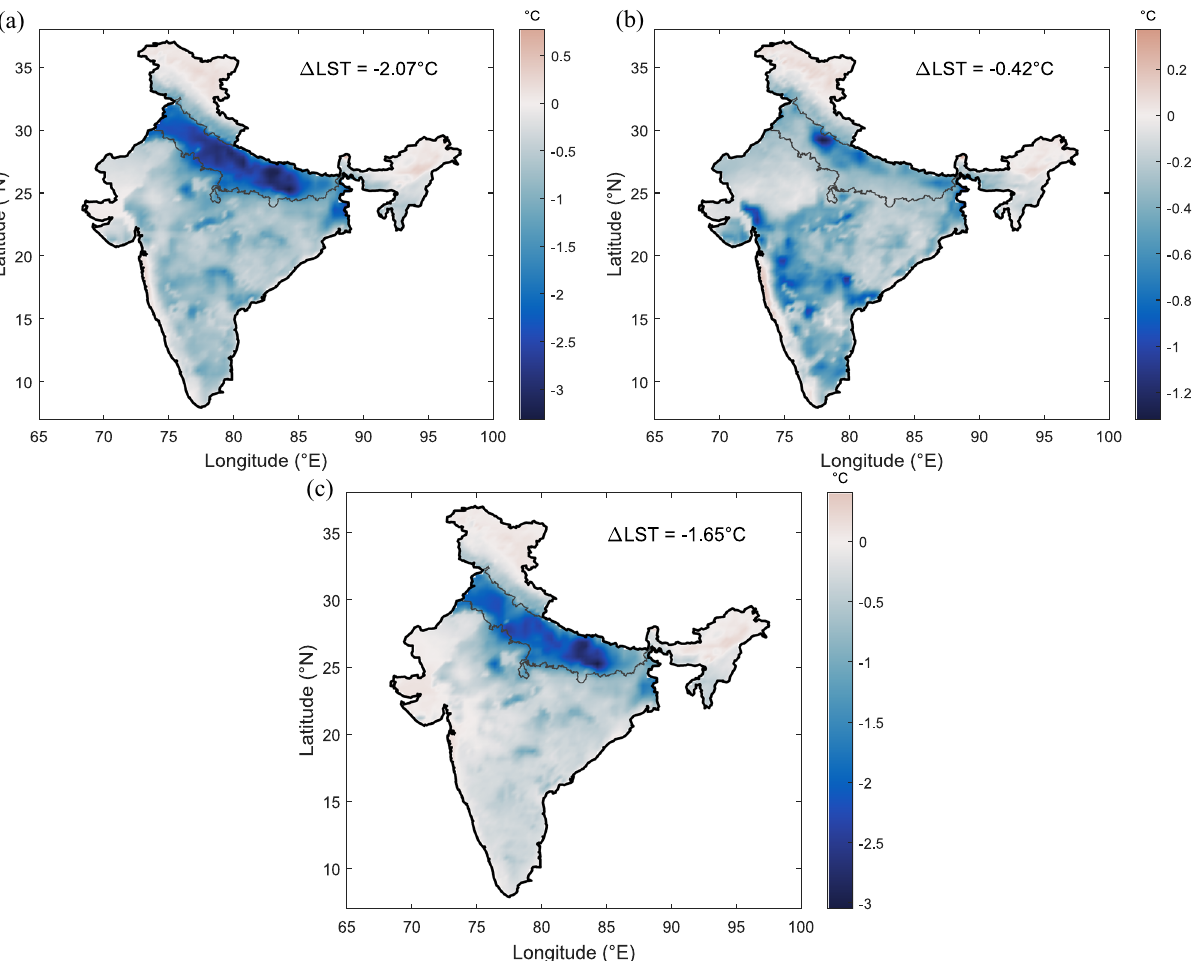
Fig. 2 In fl uence of model-estimated and agricultural census-based irrigation volume on land surface temperature (LST). Mean (2004 – 2016) difference in land surface temperature (°C) between different experiments. a In fl uence of model-estimated Irrigation (MOD — CTL). b In fl uence of agricultural census irrigation (AGR — CTL). c Magnitude of overestimation of irrigation feedback (MOD — AGR). The mean difference spatially averaged over Indo-Gangetic Plain is shown as Δ LST. CTL represents WRF-CLM4 simulation with no irrigation, AGR represents WRF-CLM4 simulation with agricultural census-based irrigation data and MOD represents WRF-CLM4 simulation with model-estimated irrigation